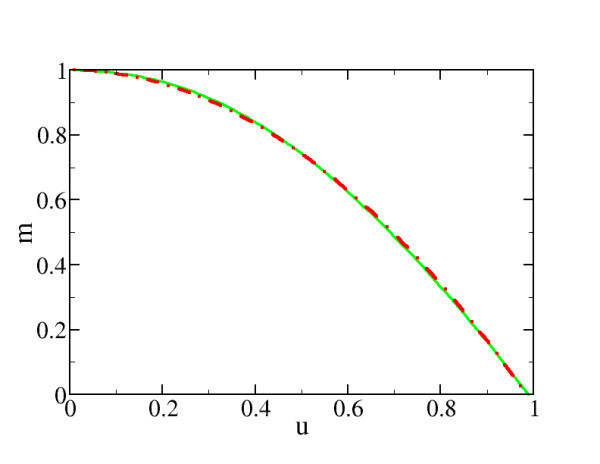
Normalized chemical potential vs. thermal energy according to Equation 9 in green solid line and parabolic approximation in red dash-dotted line.